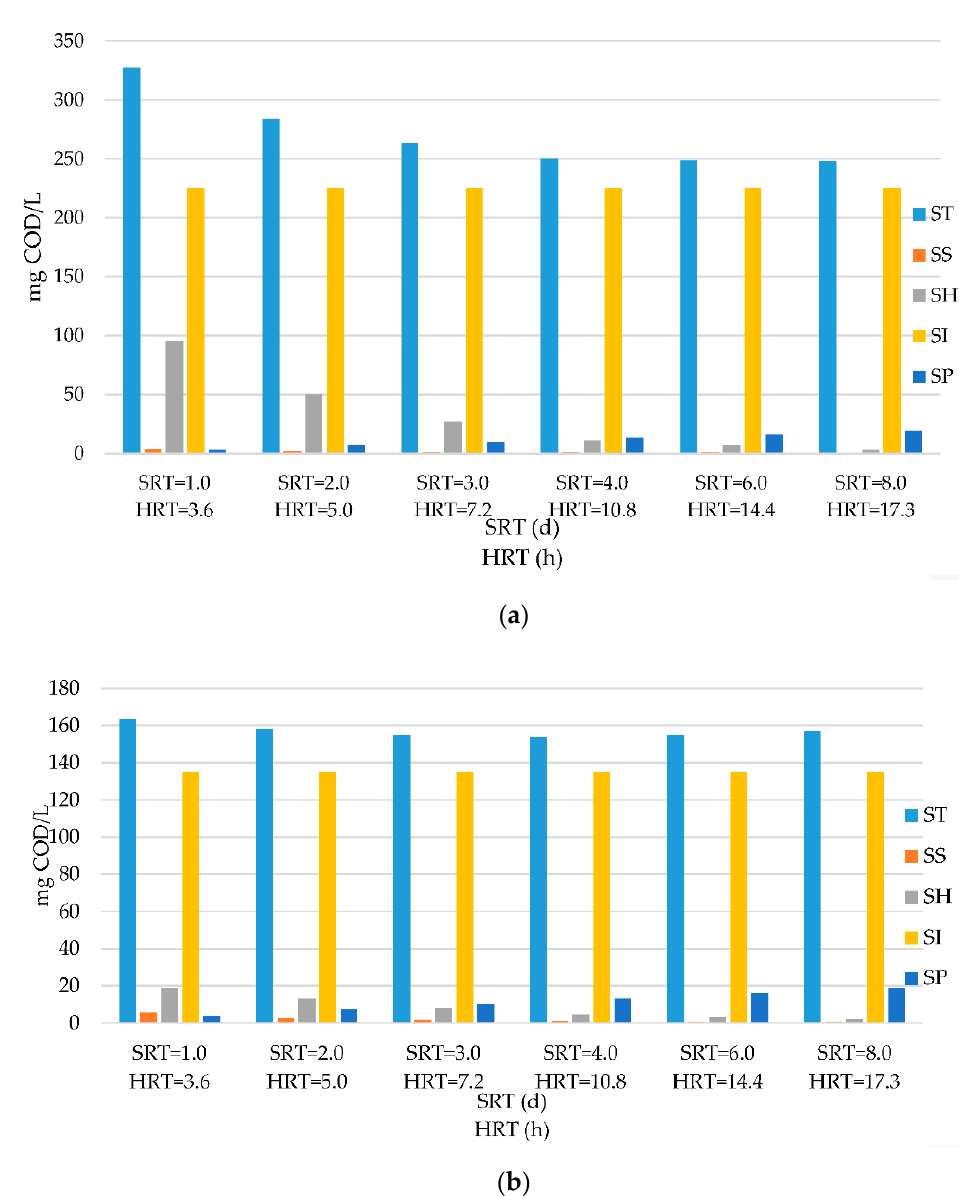
Figure 5. Effluent COD fractionation of textile wastewater operated at same HRTs in STEP 2 for ( a ) ASM1 and ( b ) MASM.